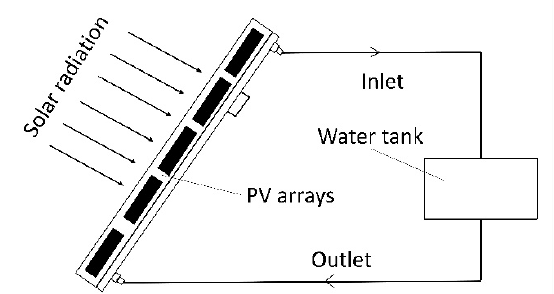
Figure 6. Schematic of Water Cooling